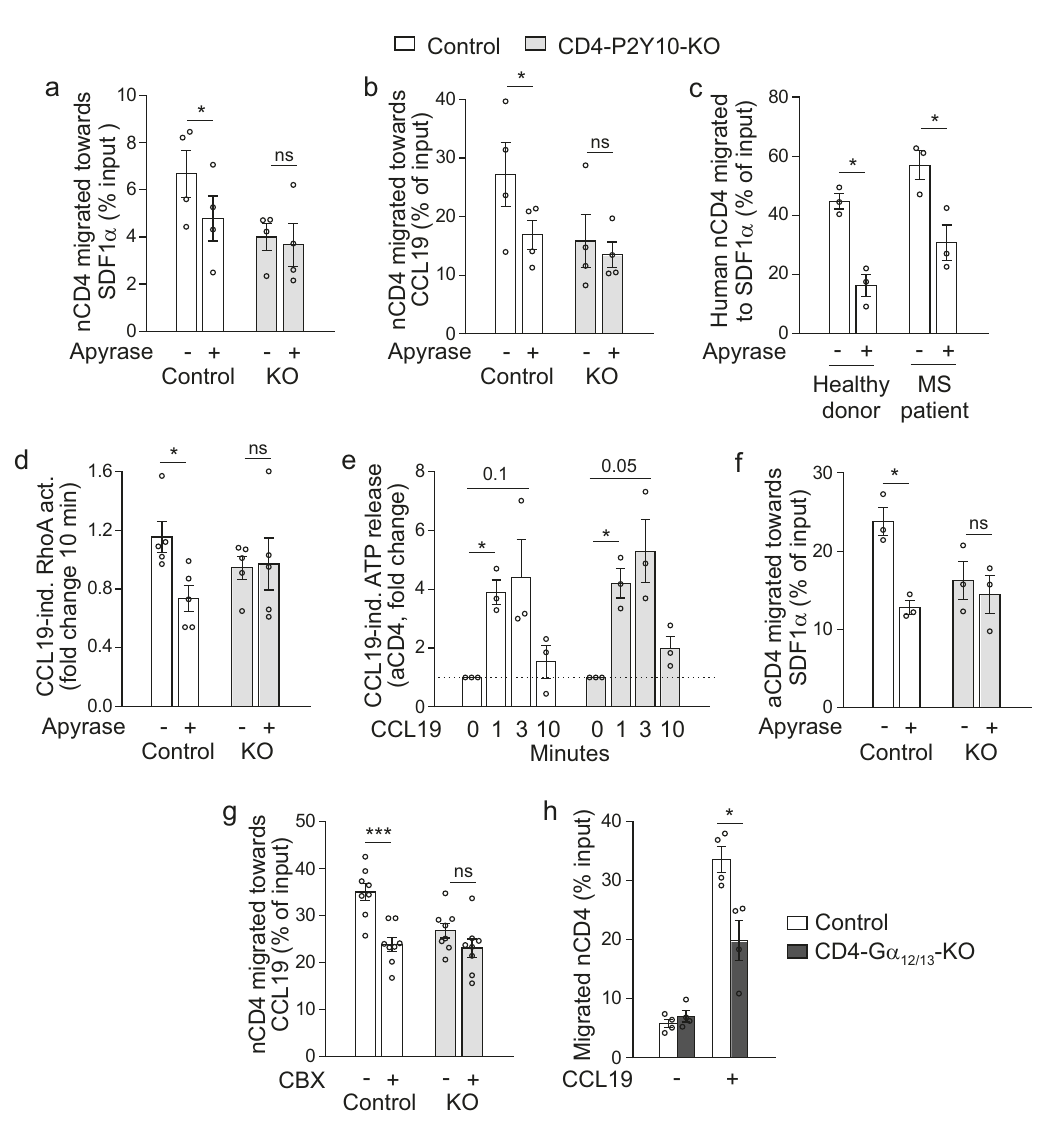
Fig. 6 ATP degradation reduces chemokine-induced RhoA activation and migration in control CD4 cells, but not P2Y10-de fi cient CD4 T cells. Effect of apyrase treatment (20 U/ml) on SDF-1 α - ( a ; *, p = 0.015) or CCL19- ( b ; *, p = 0.049) induced transwell migration in nCD4 ( n = 4 mice). c Effect of apyrase pretreatment on SDF-1 α -induced transwell migration in naïve human CD4 T cells isolated from peripheral blood of healthy donors or MS patients ( n = 3; *, p = 0.040 (healthy), 0.034 (MS)). d Effect of apyrase pretreatment on CCL19-induced RhoA activation in nCD4 ( n = 5 – 7; *, p = 0.027). e Changes in extracellular ATP concentration after CCL19 stimulation (100 ng/ml) in aCD4 ( n = 3; *, p = 0.021 (contr/1 min), 0.024 (KO/1 min)). f Effect of apyrase pretreatment on SDF-1 α -induced transwell migration in aCD4 ( n = 3 mice; *, p = 0.034). g Effect of carbenoxolone (CBX, 5 μ M, 30 min pretreatment) on CCL19-induced transwell migration in murine nCD4 ( n = 8; ***, p < 0.001). h CCL19-induced transwell migration in nCD4 from control mice and CD4-G α 12/13 -KOs (four mice per group; *, p = 0.014). Data are means ± SEM; comparisons between groups were performed using two-tailed paired ( a – d , f ) or unpaired ( h ) t test or two-tailed one sample t-test versus 1 ( e ). n , number of mice or human donors, respectively.